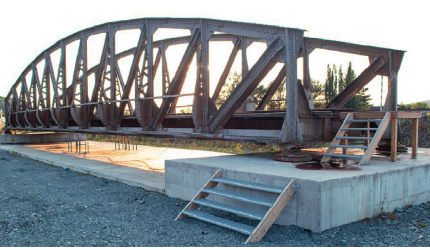
Figure 1: Hell Bridge Test Arena.